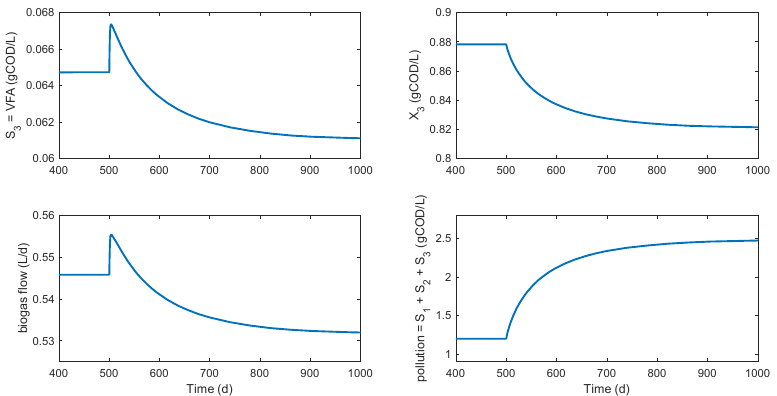
Figure 1. Base numerical simulations of two main MAD model variables (VFA and X 3 concentrations in gCOD/L), biogas flow (L/d), and organic pollution level (gCOD/L), including the effect of a step change in the dilution rate at t = 500